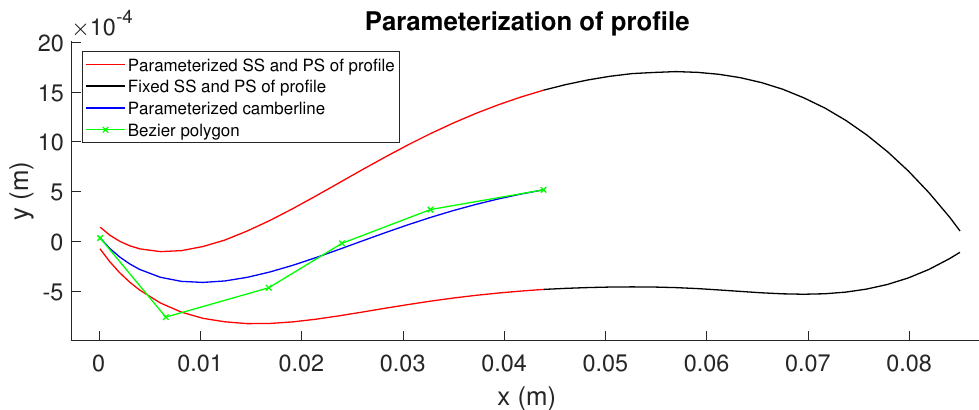
Figure 5. Parameterization of the baseline profile. Y-axis amplified for